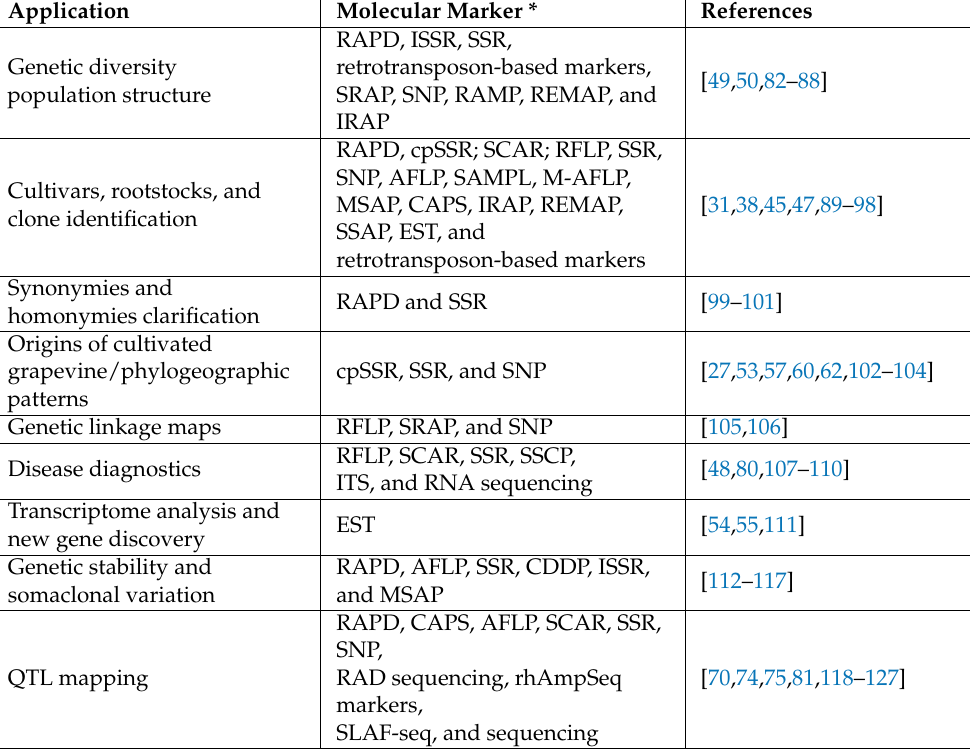
Table 1. Application of the most widely used molecular markers in